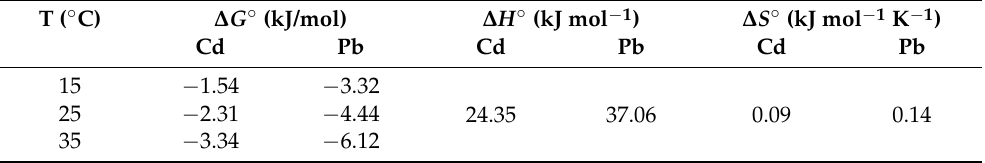
Table 7. Thermodynamic parameters of Pb(II) and Cd(II) adsorption on Sargassum biomass. T ( ◦